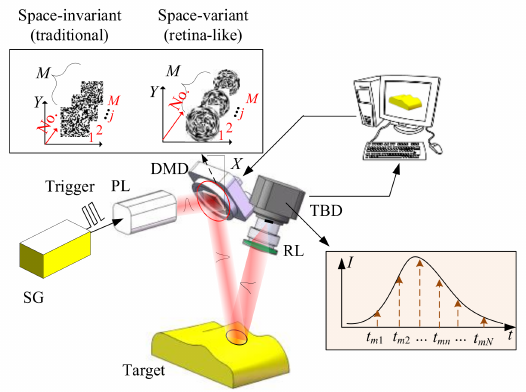
Figure 15. Principle of R-3DCGI.